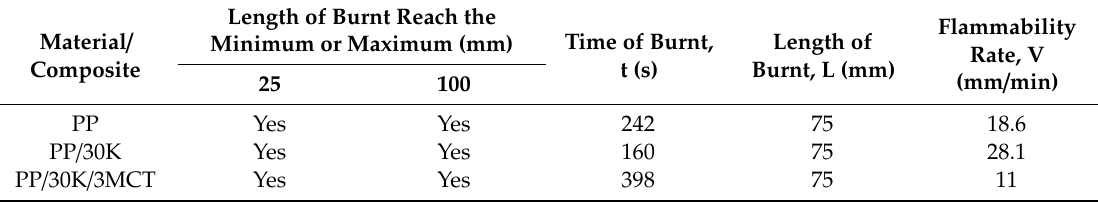
Table 3. Horizontal flammability rate of pure PP and kenaf / PP